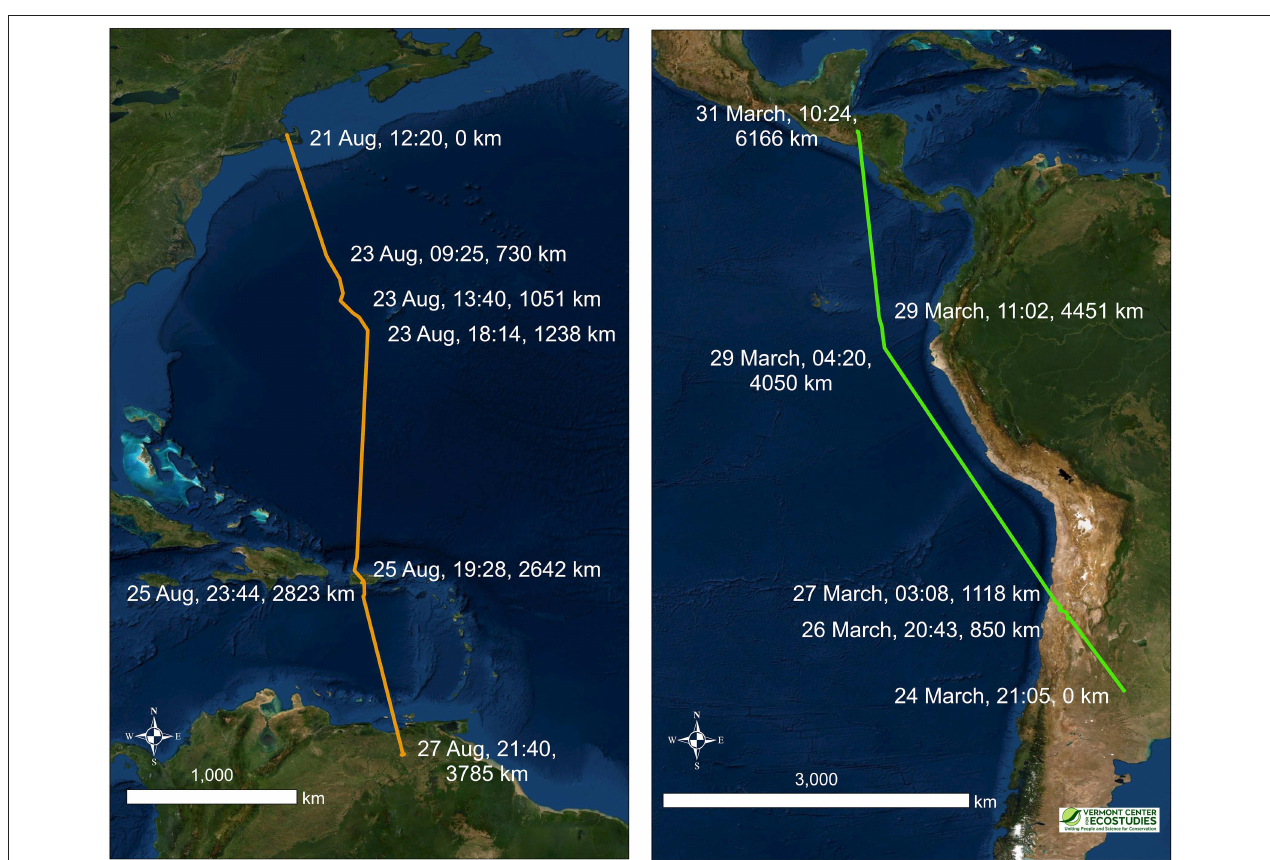
FIGURE 4 | Two examples of migratory segments illustrating non-stop flights over long distances for multiple days by Upland Sandpipers with PTT tags, 2016–2017. Extreme migratory movements included a southbound flight of 3,785km in a 6-day period over the Atlantic Ocean from Massachusetts to Venezuela ( Left , JB-PTT-67), and a northbound flight of 6,166km in a 7-day period across the Andes and along the Pacific coast from Argentina to Honduras ( Right , KO-PTT-66). Colored lines connect consecutive locations and highlight the longest suspected non-stop segments of the migratory flights for the two birds. Annotated values for a subset of fixes in the figure include the date, time (in UTC), and the cumulative distance traveled (km). The exact times of departure and arrival were not known precisely, but we provide timestamps for fixes immediately preceding and following the non-stop flight segments. Note the difference in spatial scales between the two